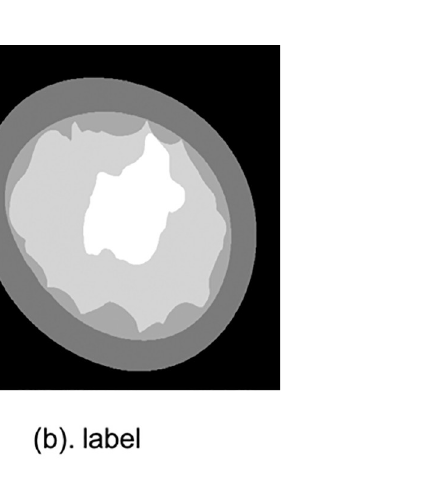
Fig 8. A sample blastocyst image from the blastocyst dataset and its manual label.